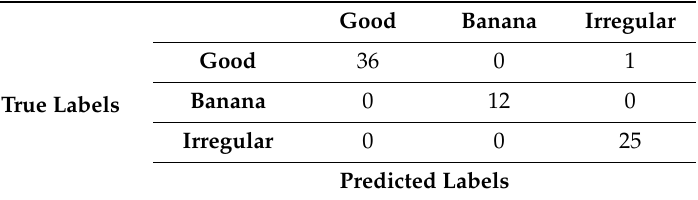
Table 3. Confusion matrix of the oyster dataset.